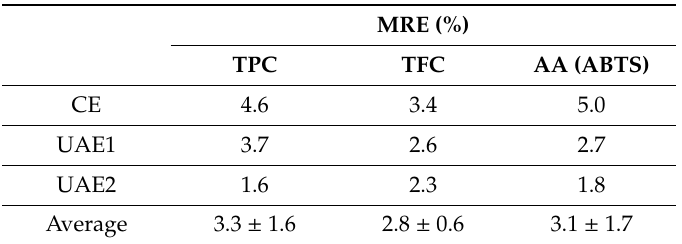
Table 4. Mean relative error (MRE) estimated by comparison of experimental and simulated extraction yield curves of total phenolic (TPC) and total flavonoid (TFC) contents, and antioxidant activity (AA) (ABTS assay) from orange byproduct by mechanical agitation (CE at 80 rpm) and acoustically assisted (UAE1 at 520 W / L; UAE2 at 790 W / L) extraction. MRE (%) TPC